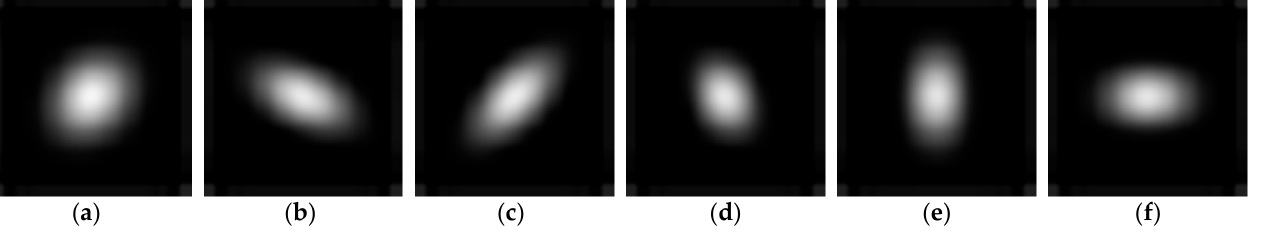
Figure 7. Six different blur kernels: ( a ) BK1; ( b ) BK2; ( c ) BK3; ( d ) BK4; ( e ) BK5; ( f ) BK6. Table 3. The mean SSDE of each method for each BK on all 100 synthetic blurred images. Image Number